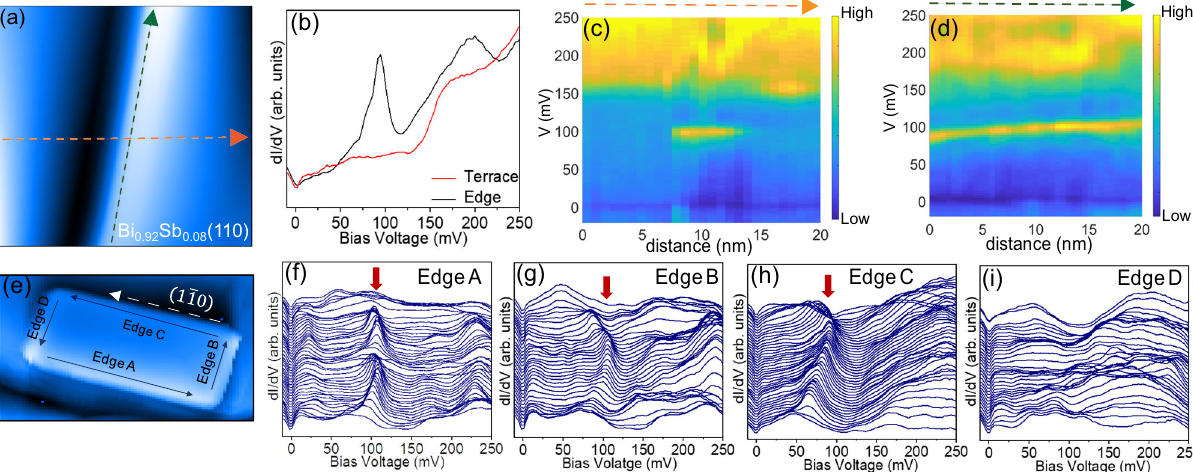
Fig. 4 STM data on Bi 0.92 Sb 0.08 (110) fi lm. a STM topographic image of 20 nm × 20 nm area of Bi 0.92 Sb 0.08 (110) fi lm, showing an island edge. b d I /d V spectra at the edge and over the island terrace (at ac modulation 3.5 mV and current 100 pA), showing the peak around 100 meV corresponding to the mode at the edge. c , d d I /d V spectra obtained across (orange dashed line in ( a )) and along (green dashed line in ( a )) the island edge, respectively. The color bars indicate the relative height of the density of states. e Topography of rectangular facet of Bi 0.92 Sb 0.08 (110) with 50 nm × 25 nm area. The four edges are marked as Edge A, Edge B, Edge C, and Edge D, respectively. The white arrow along the edge shows the (1 (cid:1) 10) direction. f − i Spectroscopic data (at ac modulation 3 mV and current 120 pA) along the four edges A, B, C, and D respectively (following the blue arrows in ( e )). A line with a constant slope was subtracted from all spectra for clarity. The raw data for these fi gures without slope subtraction is shown in Supplementary Fig. 3g − j. The red block arrows indicate the sharp peaks corresponding to the edge modes that are only seen on three of the four